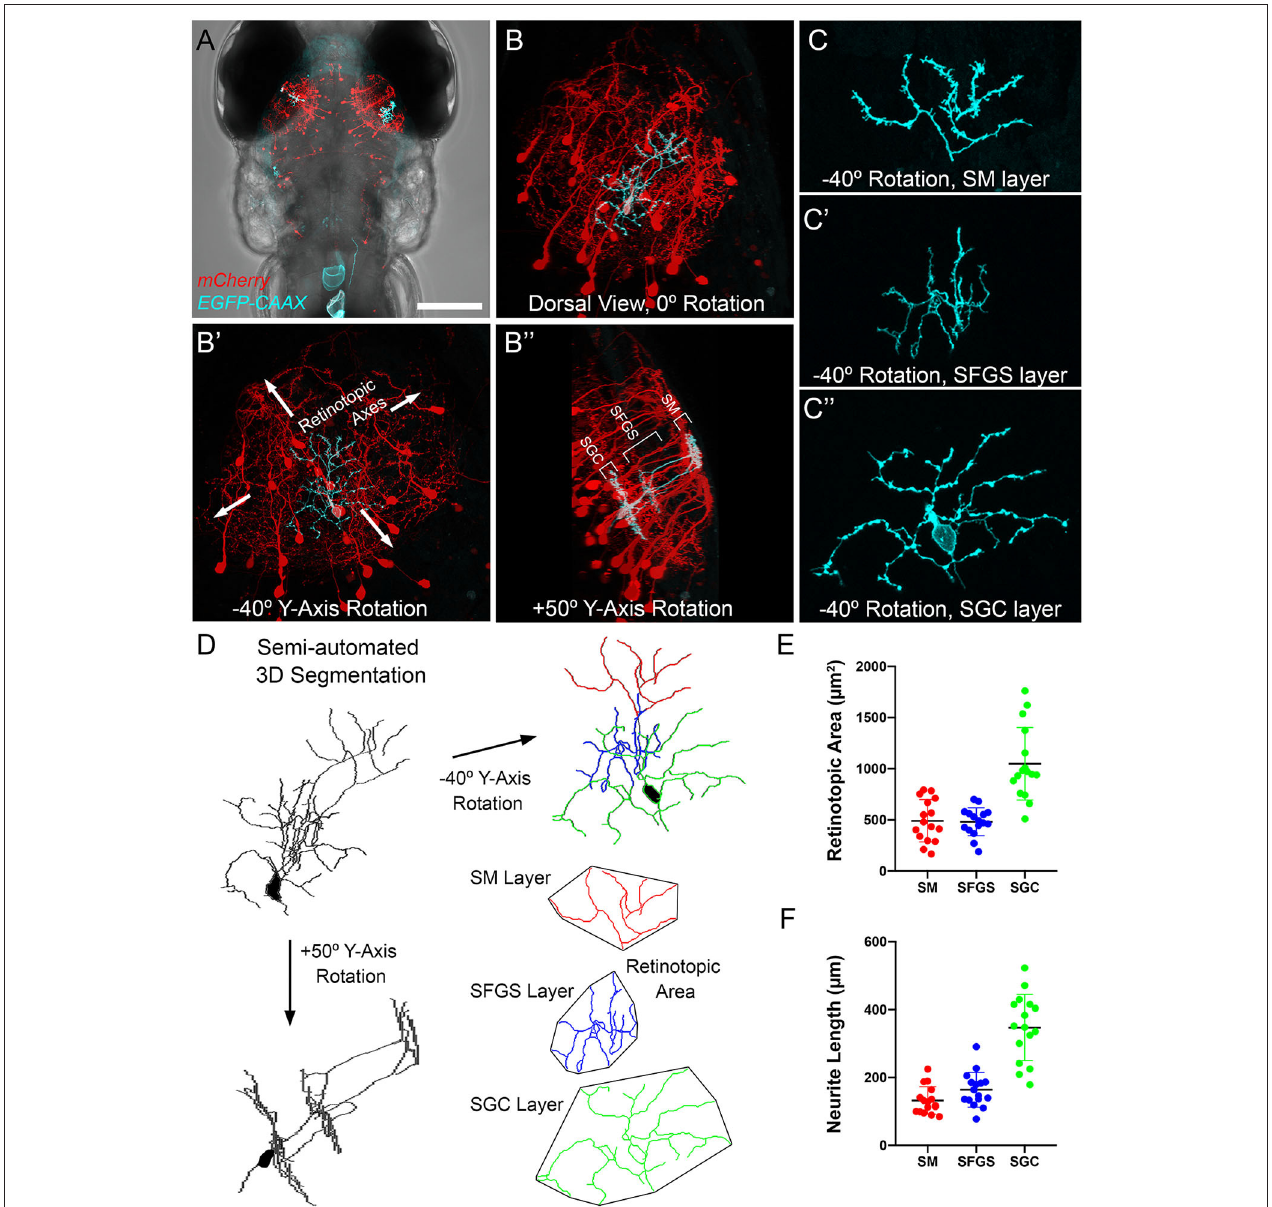
FIGURE 6 | Morphometry of PyrN arbors formed in SM, SFGS, and SGC layers of tectum. (A) Dorsal view, whole-brain confocal image volume of a 7 dpf double transgenic Tg(id2b:gal4,uas:NTR-mCherry) larva injected at the embryo stage with a uas:egfp-caax plasmid to yield sparse genetic labeling. Note single EGFP-labeled neuron in each tectal lobe. (B) Higher magnification maximum projection of neuron labeled in right tectal lobe of larva in (A) . Projection is shown from dorsal view, 0 ◦ Y-Axis rotation. Maximum projection of same neuron rotated − 40 ◦ about the Y-axis, an orientation parallel to the tectal layers (B ′ ) . Maximum projection of same neuron rotated + 50 ◦ about the Y-axis, an orientation orthogonal to the tectal layers (B ′′ ) . Note clearly stratified neurite morphology with arbors in SM, SFGS, and SGC layers of tectal neuropil. (C) High magnification views of isolated subvolumes of the SM (C) , SFGS (C ′ ) , and SGC (C ′′ ) layer dendrites of neuron in B shown with − 40 ◦ Y-axis rotation used to calculate retinotopic areas. (D) Workflow for morphological segmentation and measurement of retinotopic areas for PyrN neurite subvolumes. Semi-automated 3D segmentation produces skeletonized tracings used for neurite length and retinotopic area measurements. For direct comparison between raw images and tracings, note that skeletonized tracing was obtained from PyrN shown in (B,C) . (E,F) Quantification of retinotopic area and neurite length measurements for the different PyrN neurite subvolumes: SM, SFGS, and SGC. Scale bar: 200 µ m in (A) , 50 µ m in (B) , 15 µ m in (C) , and 20 µ m in (D) .